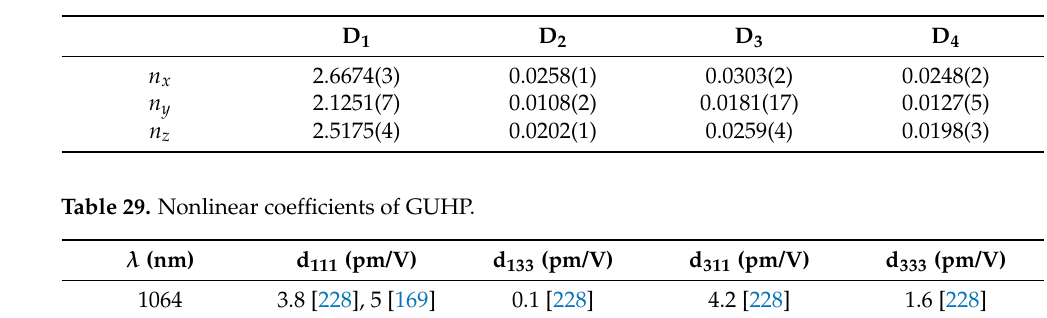
Table 28. Sellmeier parameters for the refractive index dispersion of Equation (29). Adapted with permission from [154]. © John Wiley and Sons.